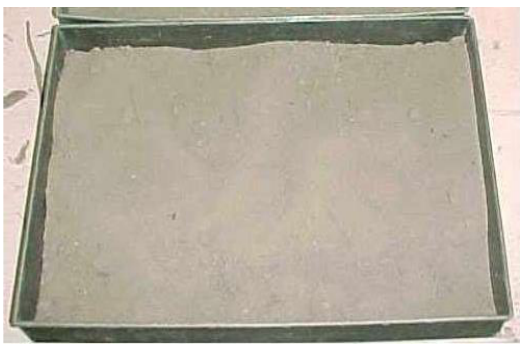
Figure 2. Natural soil – Silt sand.